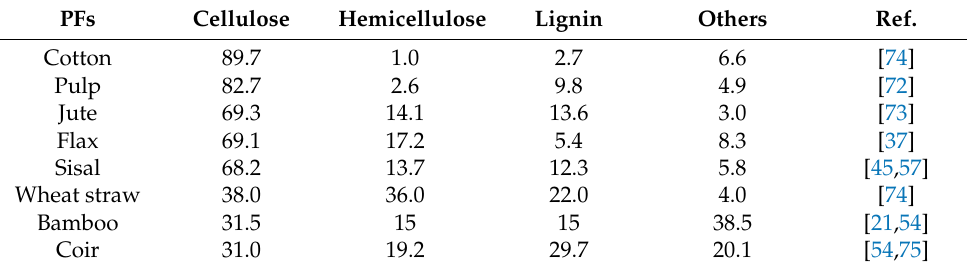
Table 2. Chemical composition of